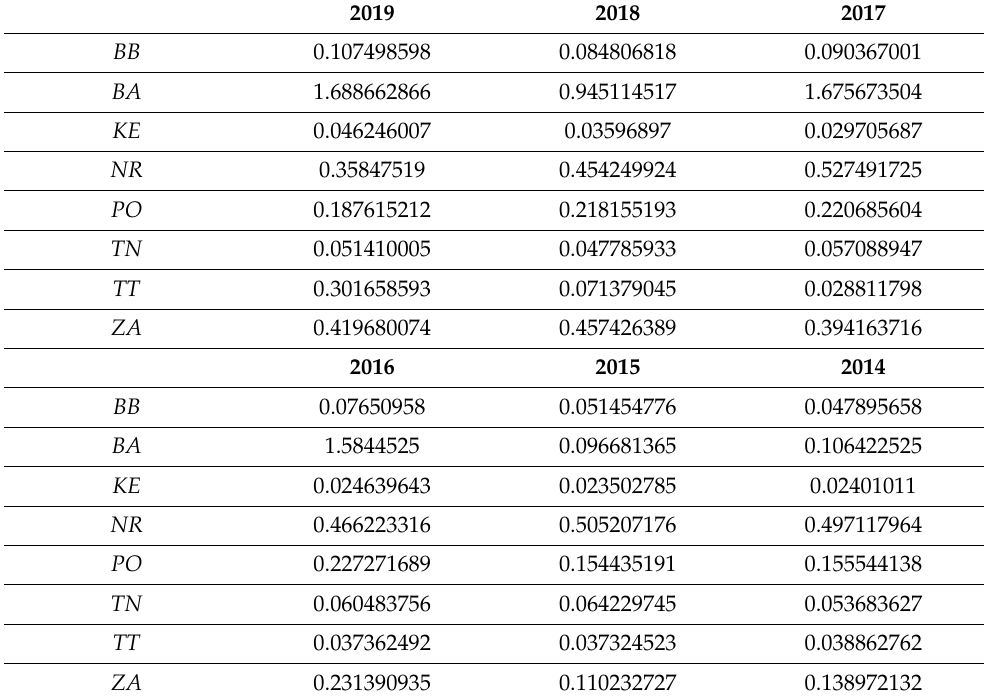
Table 1. ERI CO values during